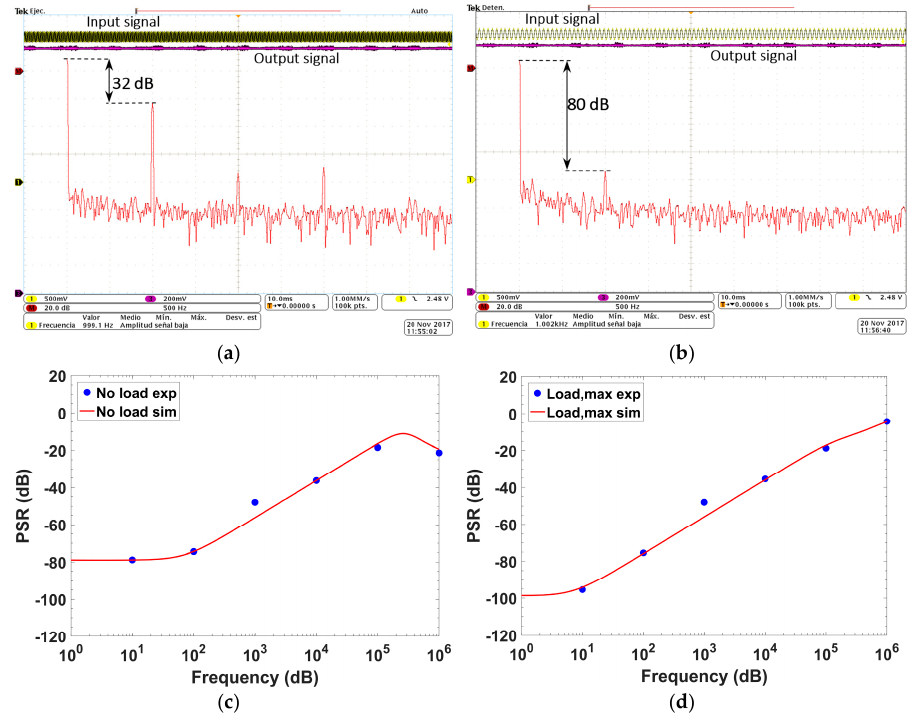
Figure 14. Oscilloscope screenshot for PSR calculation: ( a ) FFT of the input signal; ( b ) FFT of the output signal. PSR over frequency for: ( c ) minimum load; and ( d ) maximum load.